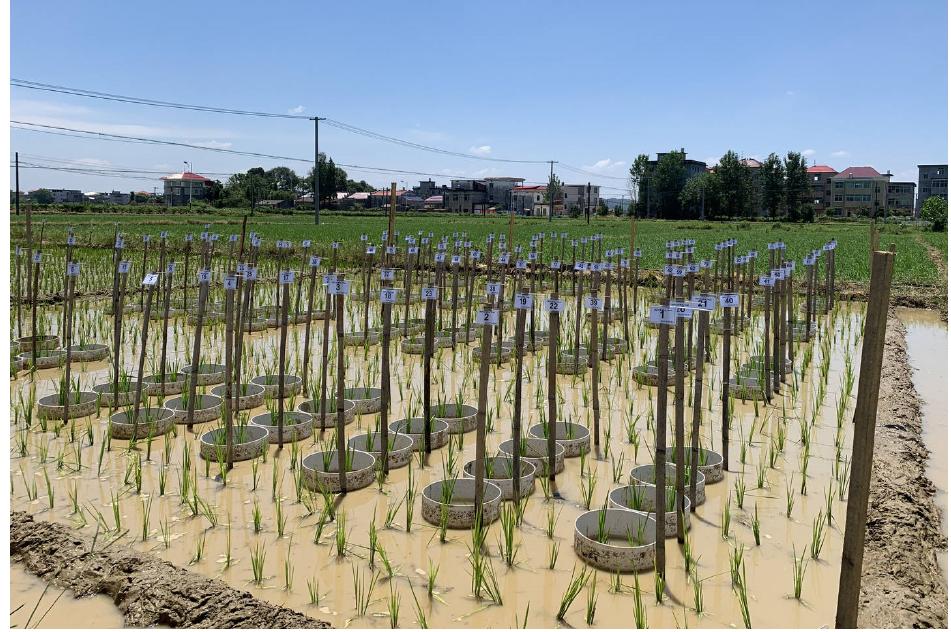
Figure 2. Setup with PVC tubes of micro-plot experiment in 2021.